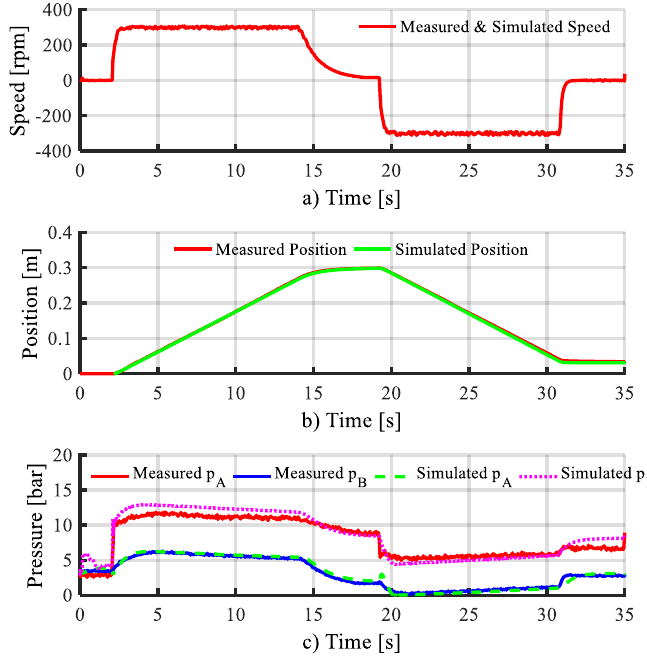
Figure 9. Validation of the DPC model: ( a ) input speed, ( b ) cylinder position, ( c ) pressures in chambers A and